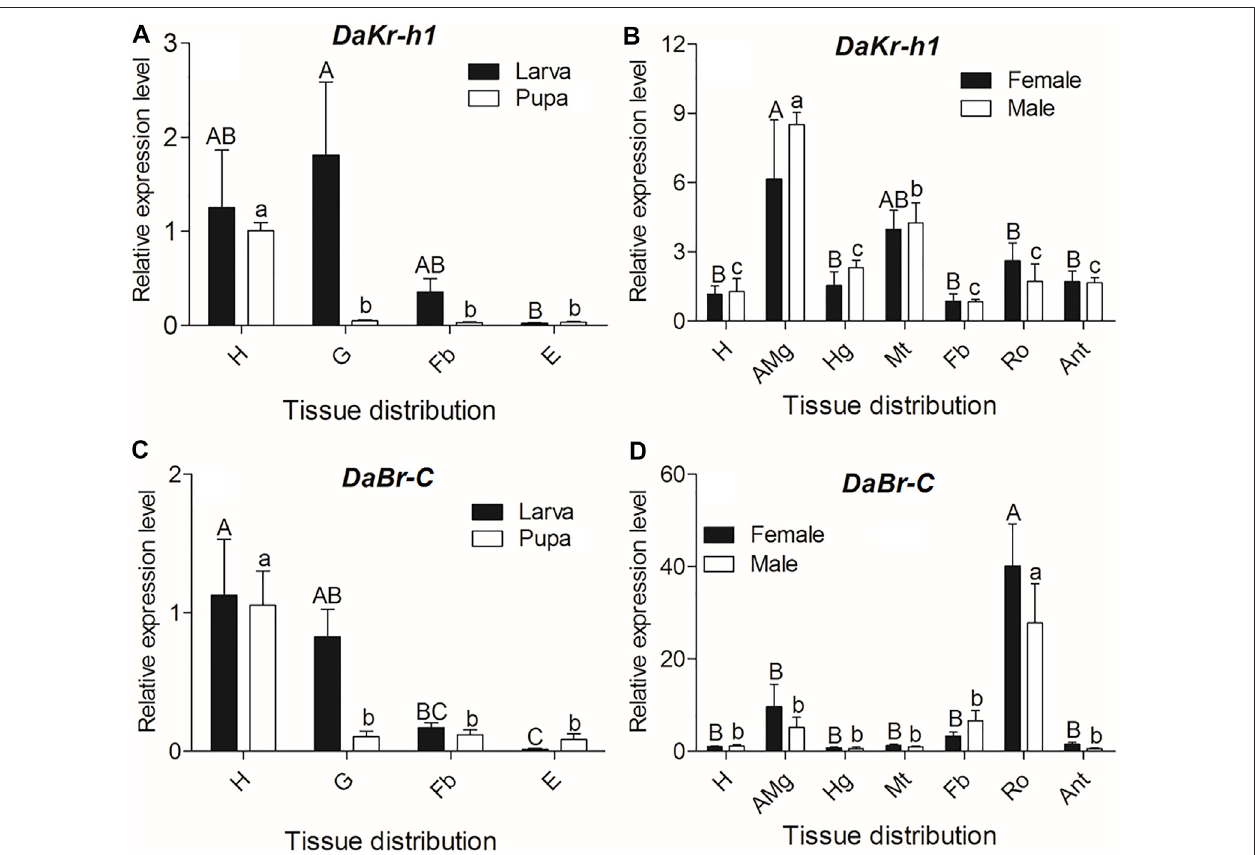
FIGURE 3 | Quantitative expressions of DaKr-h1 and DaBr-C genes (means ± SE) in different tissues of larva, pupa, and emerged adult. The tissues include head (H), anterior midgut (AMg), hindgut (Hg), Malpighian tubule (Mt), fat body (Fb), reproductive organs (Ro: testes of males and ovaries of females), antennae (Ant), gut (G), and epidermis (E)of D.armandi .Dataaremeans±SEofthreeindependentexperiments. Inboth graphs,transcriptlevelsareshownrelativetothehead(H)ofmalesand females. All templates were normalized with CYP4G55 and β -actin . The 2 − ΔΔ Ct and SE values were used for plotting the graphs. Uppercase letters indicate signi fi cant differences of females or larvae, whereas lowercase letters indicate signi fi cant differences of males or pupae.